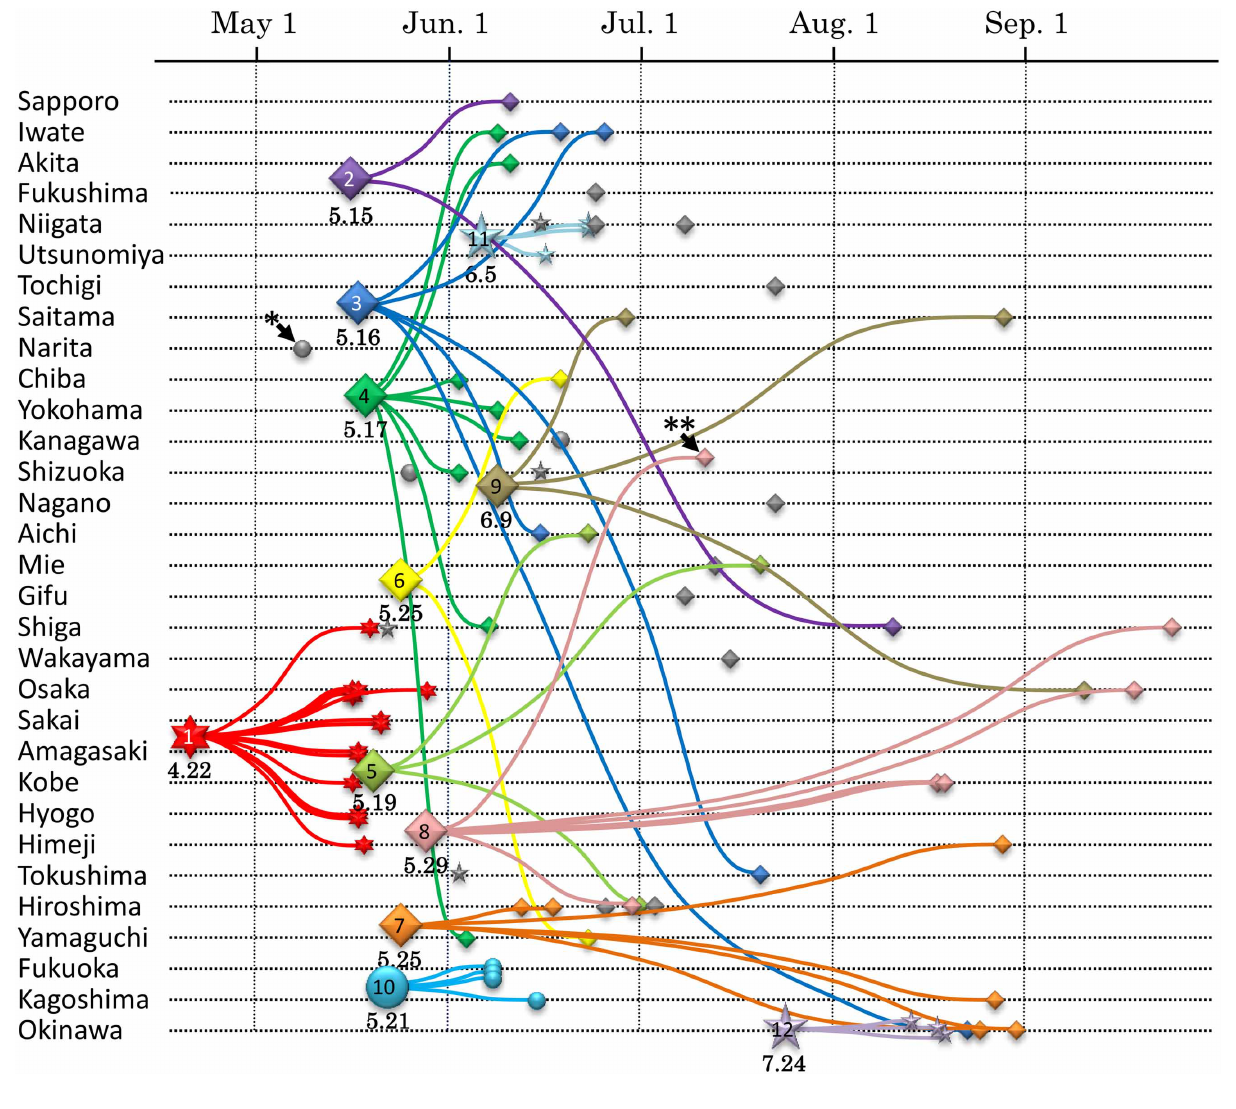
Rambaut, 2007). Seventy-five isolates of A(H1N1)pdm viruses from Japan are plotted with the small symbols. The MRCA of each transmission network inferred from the phylodynamics are plotted with the large symbols. The numbers below the large symbols display the tMRCA date. This figure is cited from Figure 4 in our previous report (Shiino et al.,